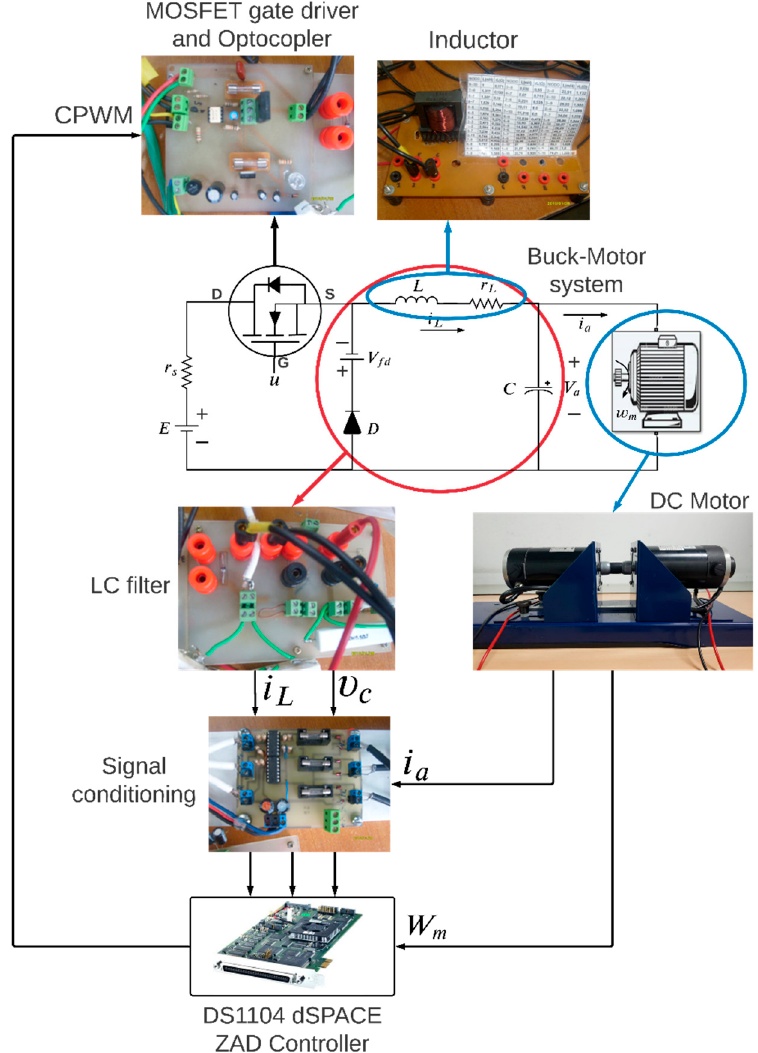
Figure 6. Experimental platform for validating the ZAD control.